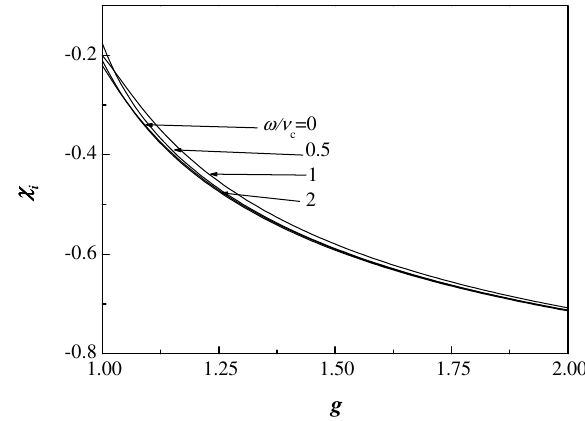
FIG. 2. Plots of the normalized real frequency 2 geometrical factor g obtained from Eq. (38) for parameters identical to Fig. 1.